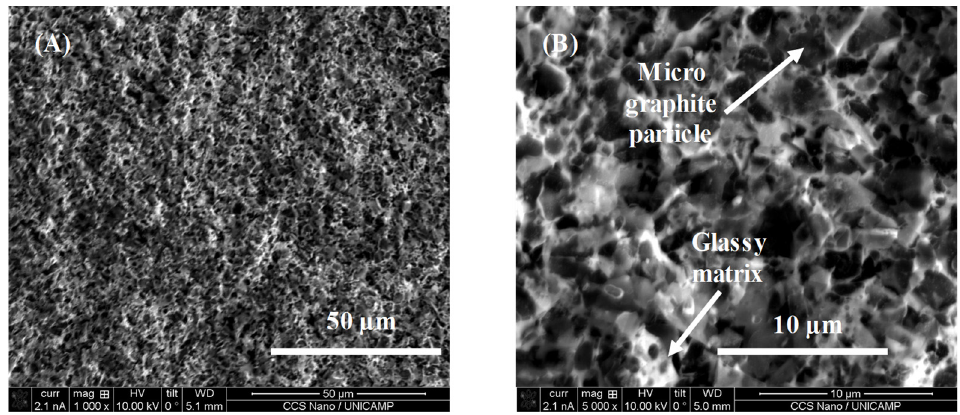
Figure 6. Scanning electronic microscopy image of the piezoresistive film surface, sample 102. Scale bars 50 μ m ( A ) and 10 μ m ( B ). Arrows show the positions of micrographite particles (top) and glassy matrix (bottom).